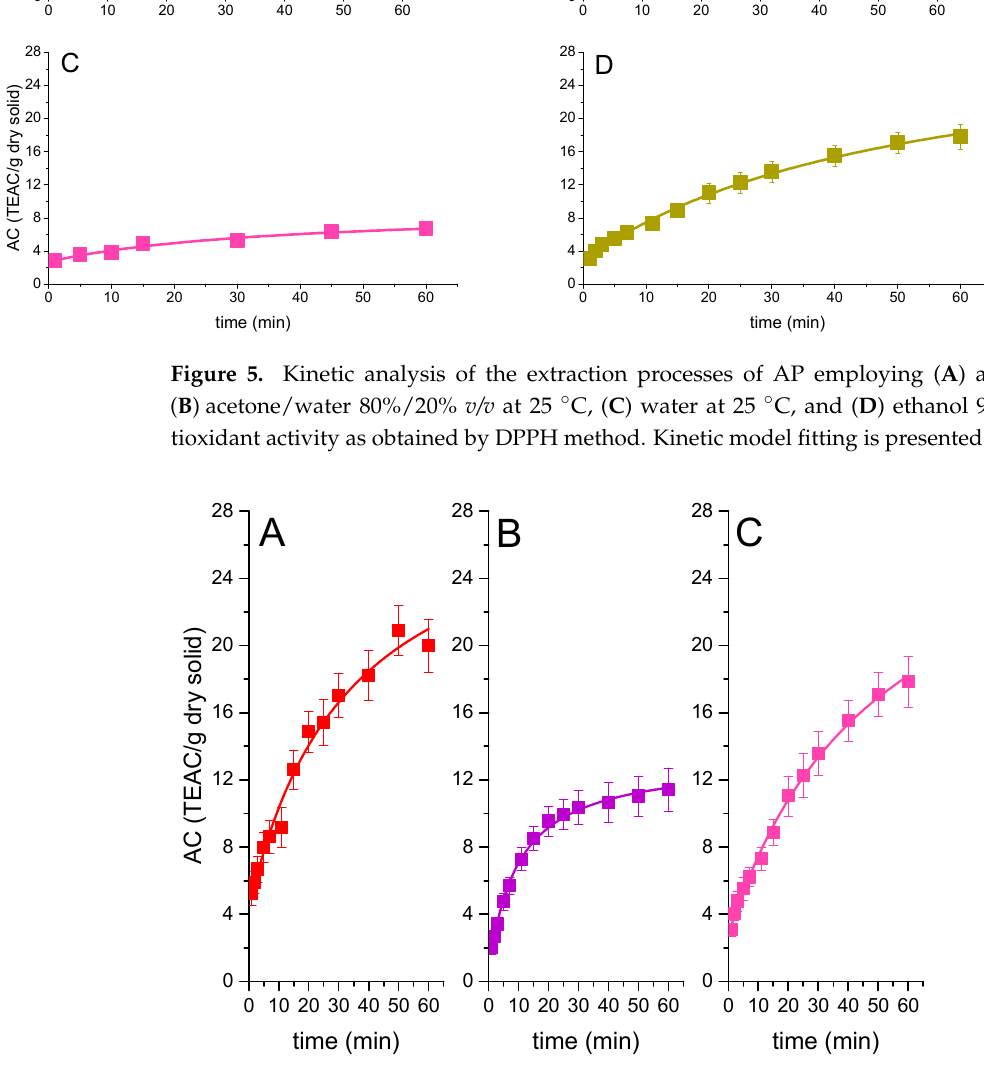
Figure 6. Kinetic analysis of the extraction processes of AP with glycols and a glycol-based DES at 70 ◦ C. ( A ) ethylene glycol 90%, ( B ) propylene glycol 90%, and ( C ) ChCl:Gly 90%. The kinetic model fitting is presented in lines.